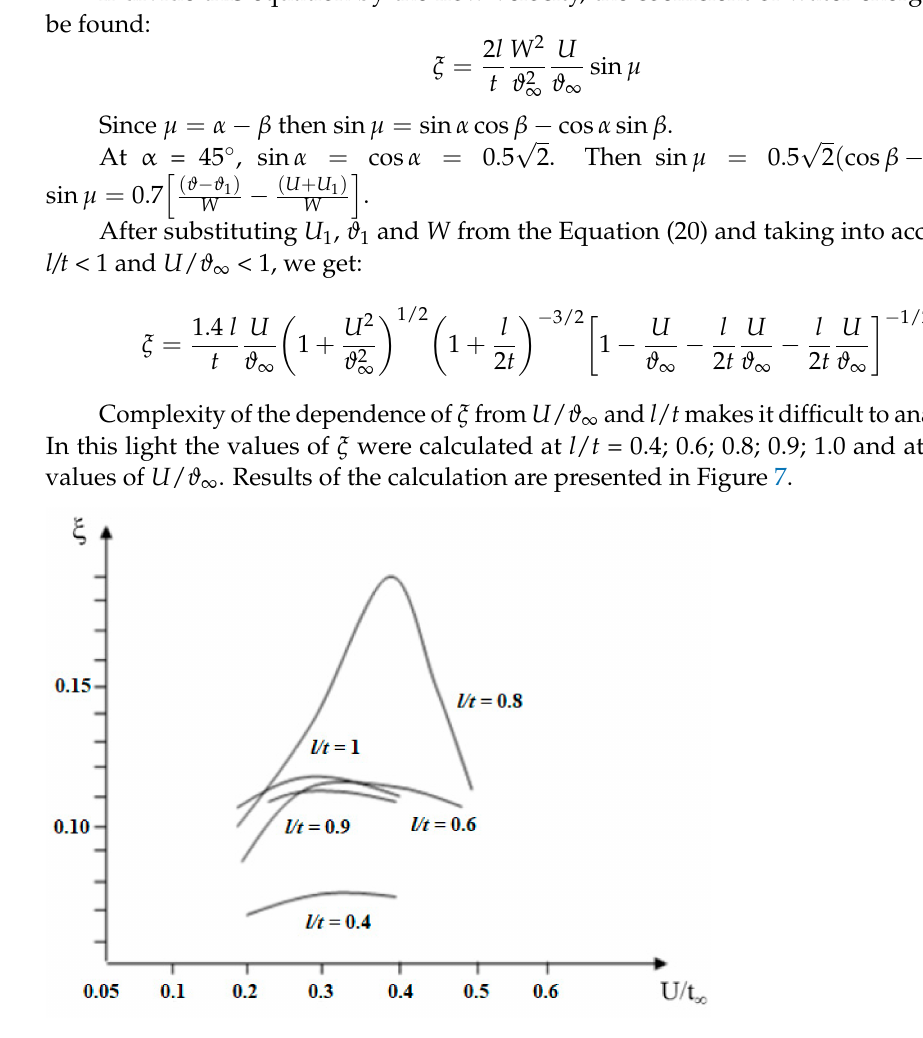
Figure 7. Dependence of ξ from U / ϑ ∞ and l / t